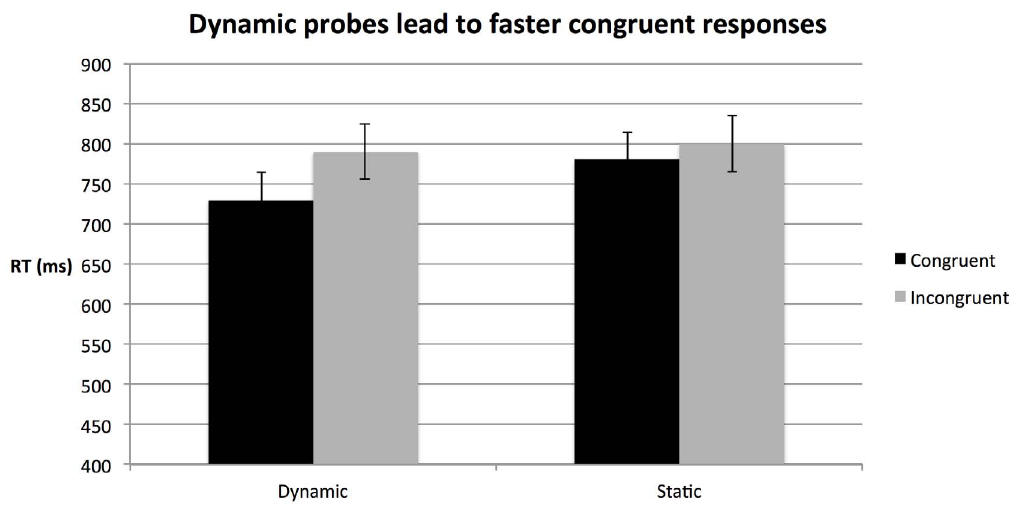
Figure 3. Dynamic facial motion by the cued face led participants to more quickly correctly identify the probe face as ‘‘congruent’’ than as ‘‘incongruent.’’ Static facial cues did not have this effect.